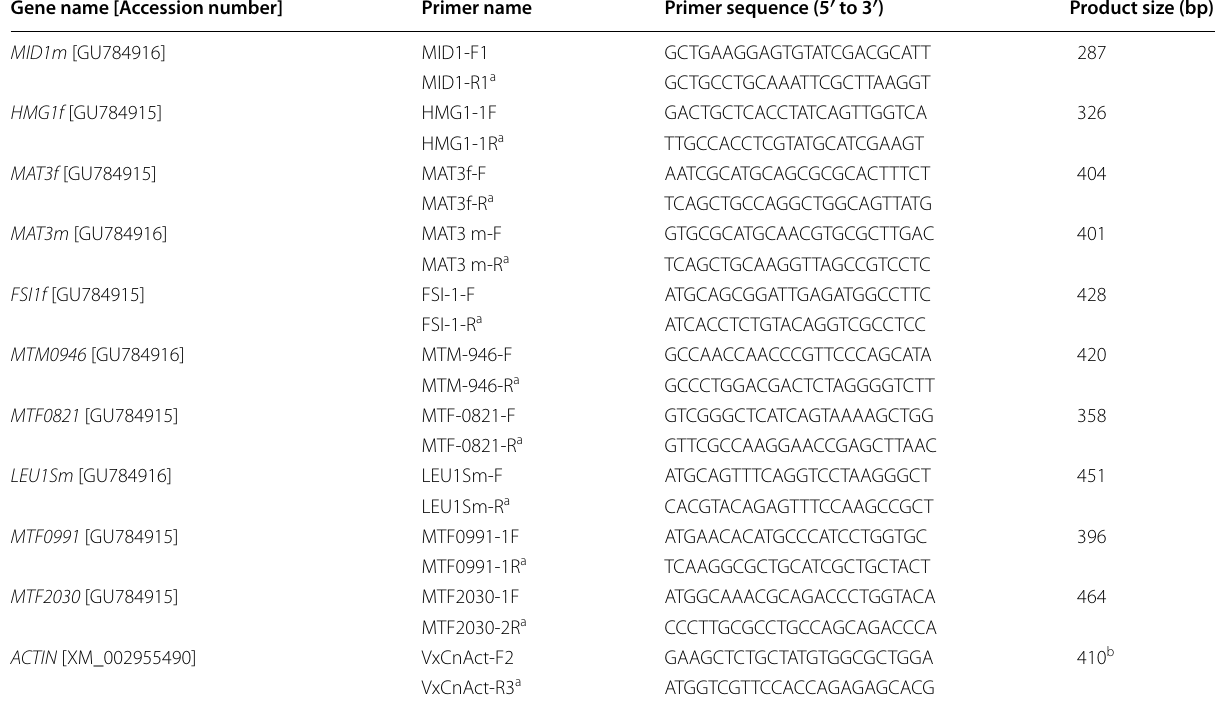
Table 2 Primer sequences and product sizes of sex-specific genes, sex-based divergent genes MAT3 and LEU1S (Fig.